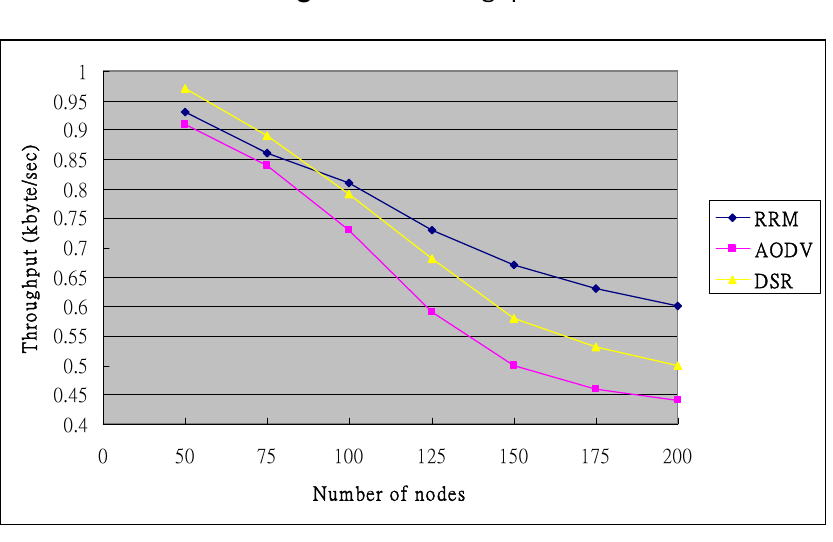
Figure 19. Throughput.